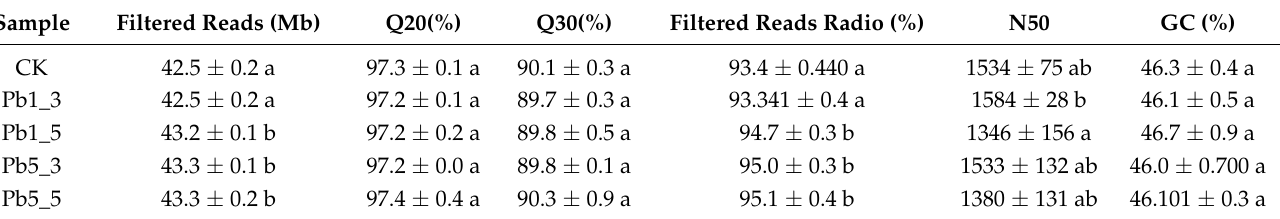
Table 1. The reads and the quality index of